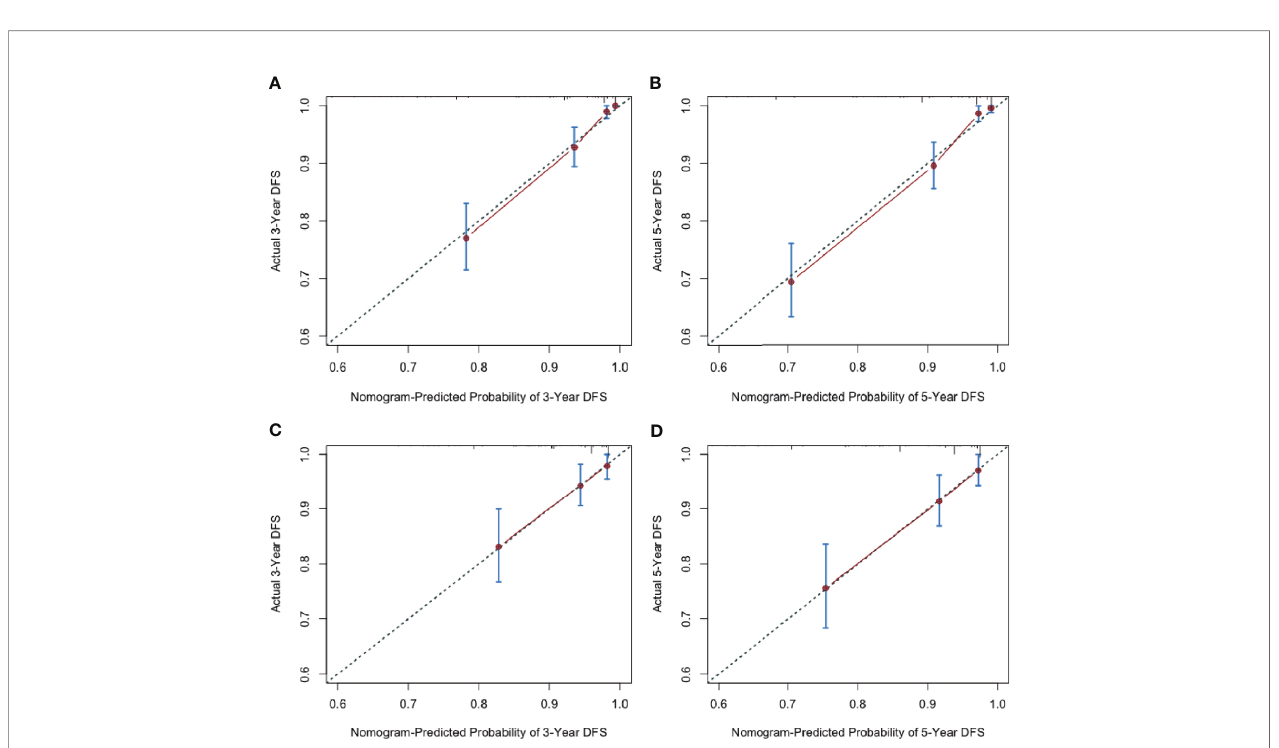
FIGURE 4 | Nomogram calibration curves for predicting disease-free survival probabilities (A) at 3 year and (B) 5 years in the training cohort; at 3 year (C) and 5 years (D) in the validation